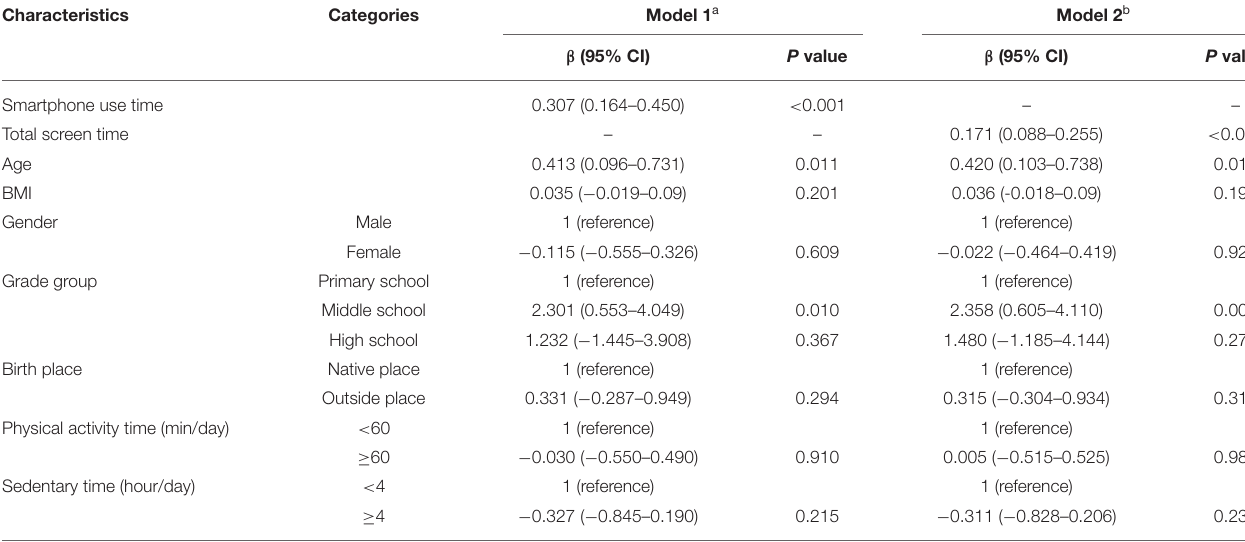
TABLE 2 | Associations of smartphone use time or total screen time with academic stress score by multiple linear regression.